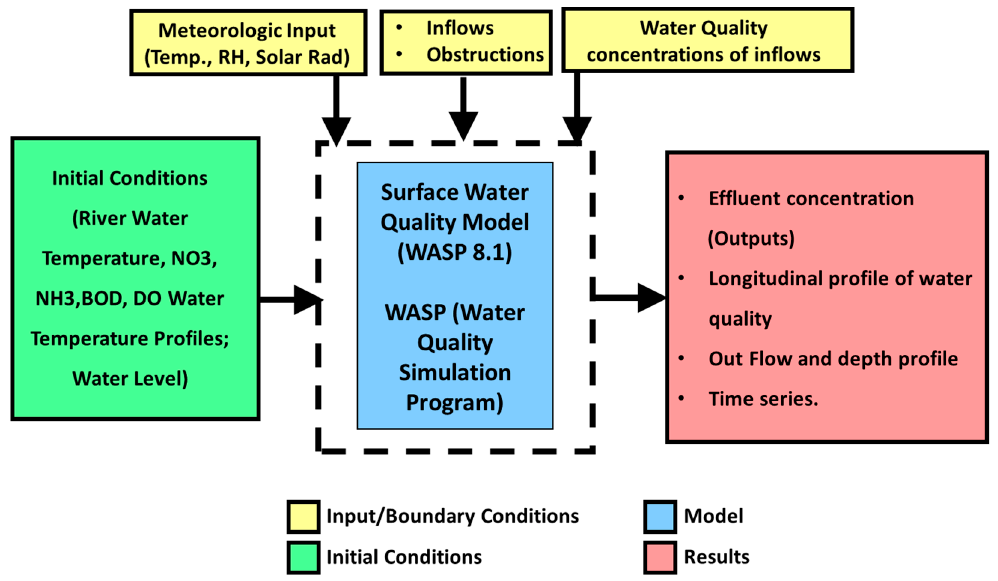
Figure 3. Description of model application approach.